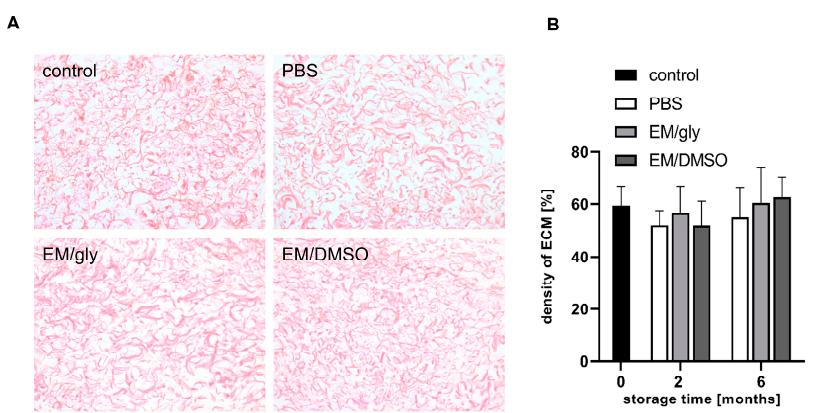
Figure 1. Histological evaluation of fresh PDC (control) and PDC stored in PBS (at 4 °C), in EM/gly (at − 80 °C) and in EM/DMSO (at − 196 °C). H&E-stained images after storage for six months, scale = 100 µm) ( A ) as well as image analysis ( B ) demonstrated preserved collagen bundles and a maintained ECM density without significant differences between PDC of different storage methods ( p ≥ 0.74, n = 4).